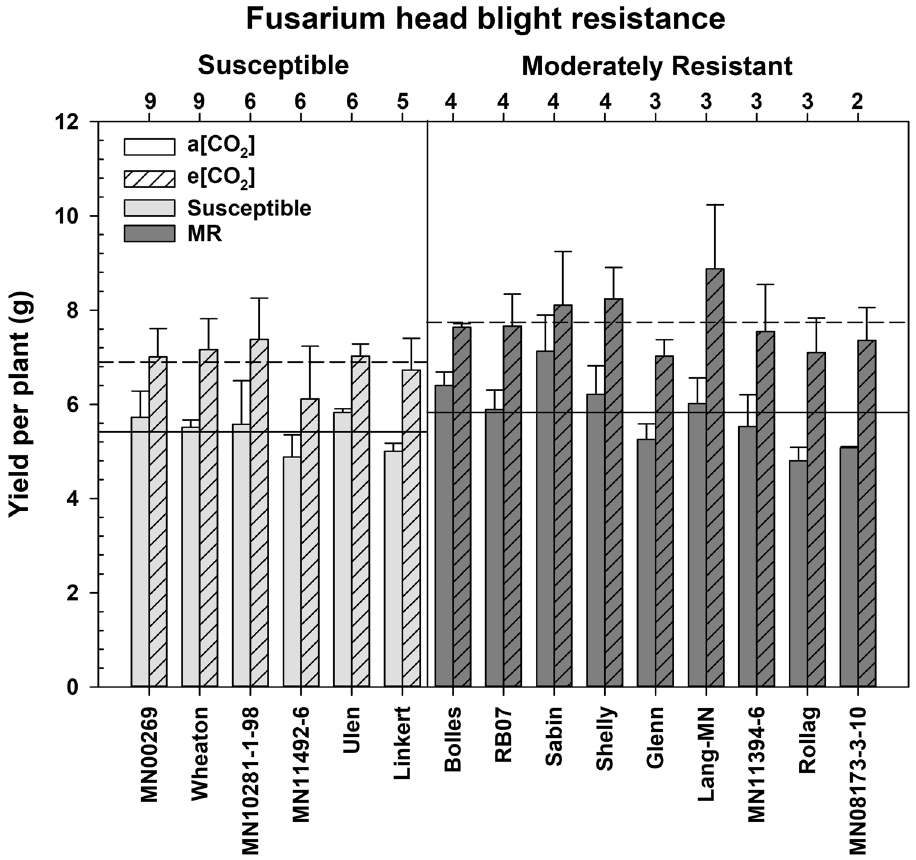
Figure 2. Differences in yield per plant of various Fusarium head blight (FHB) moderately resistant (MR) and susceptible wheat cultivars at ambient CO 2 (a[CO 2 ]) and elevated CO 2 (e[CO 2 ]), ordered by FHB resistance score at the top of the figure panel. Solid and dashed lines represent the mean yield per plant for each FHB resistance group at a[CO 2 ] and e[CO 2 ],